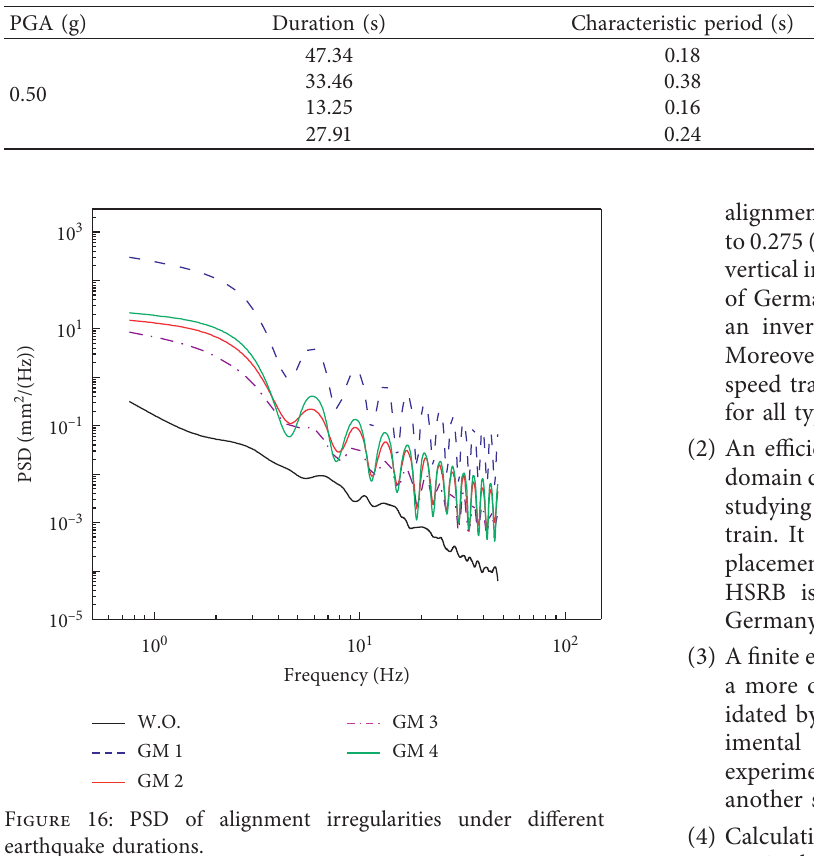
Table 6: Magnitudes of rail irregularity under different earthquake durations.